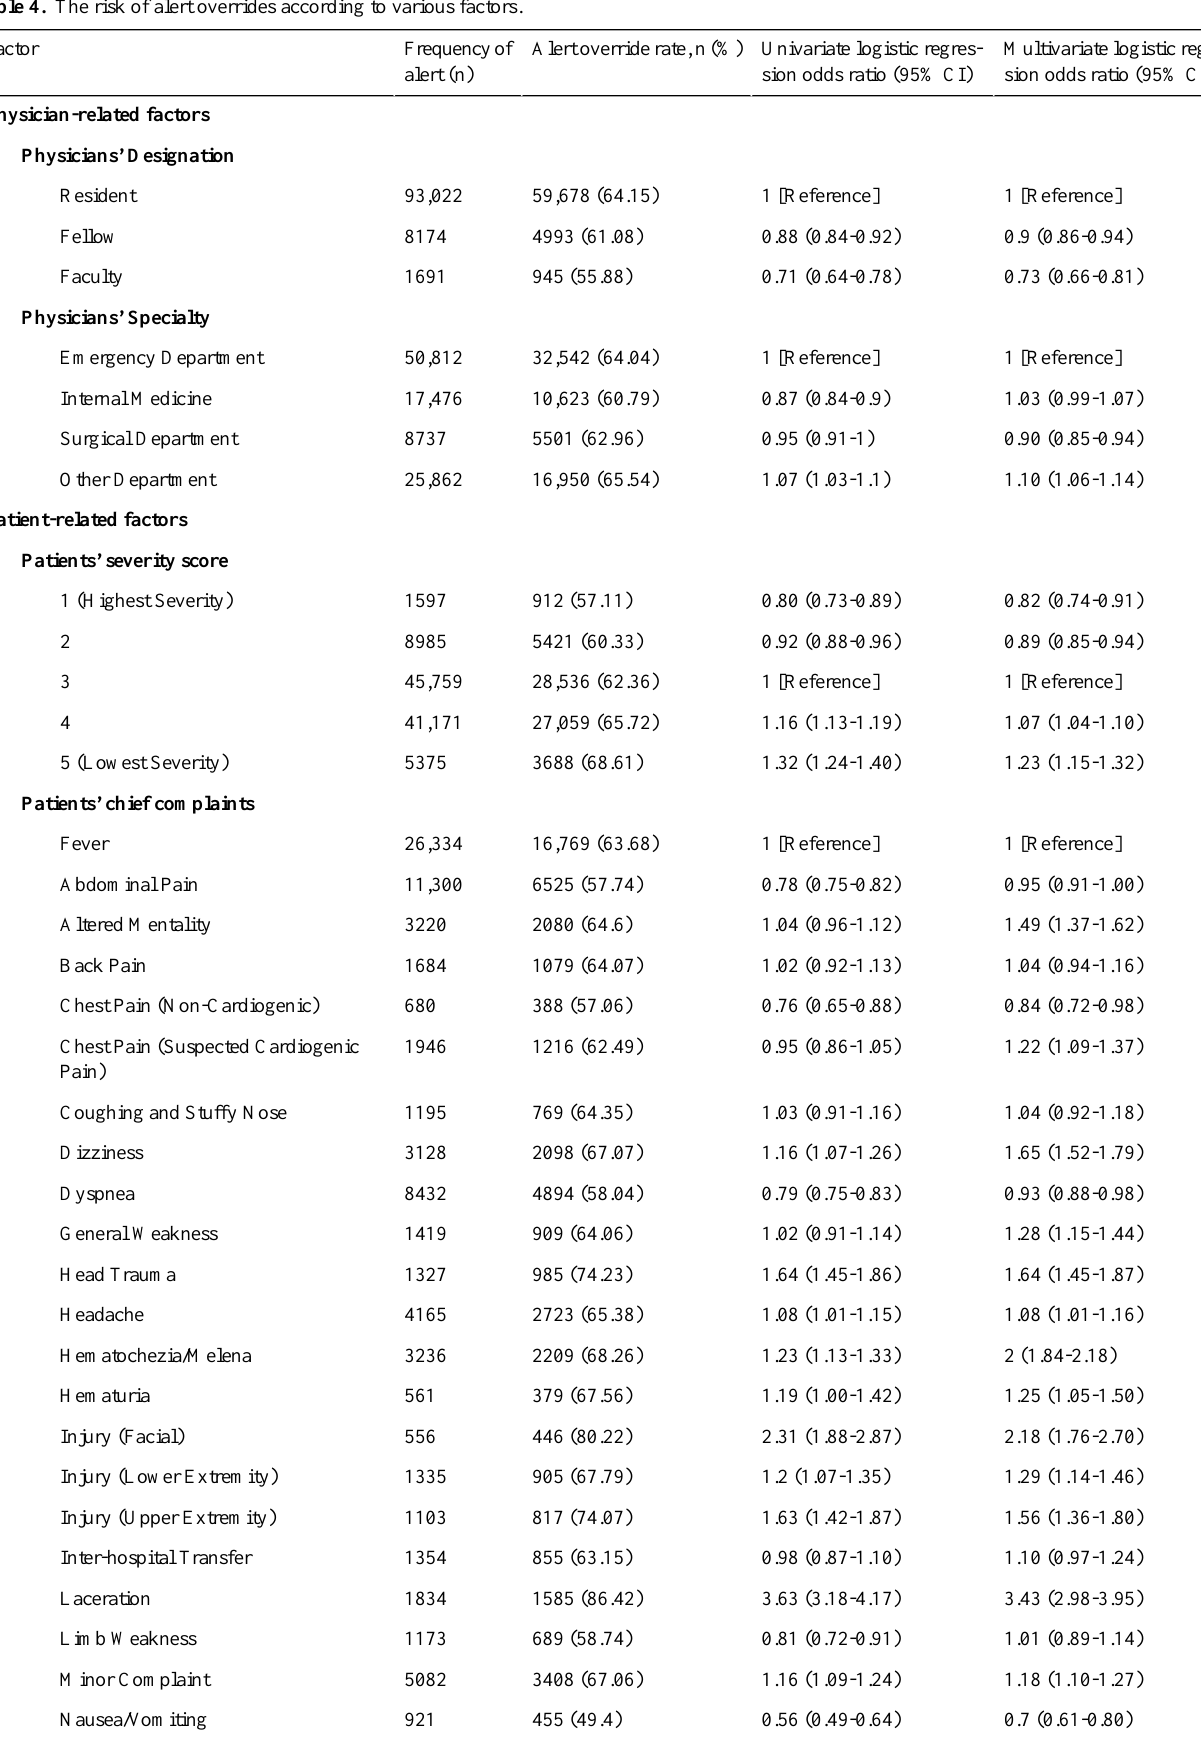
Table 4. The risk of alert overrides according to various factors.